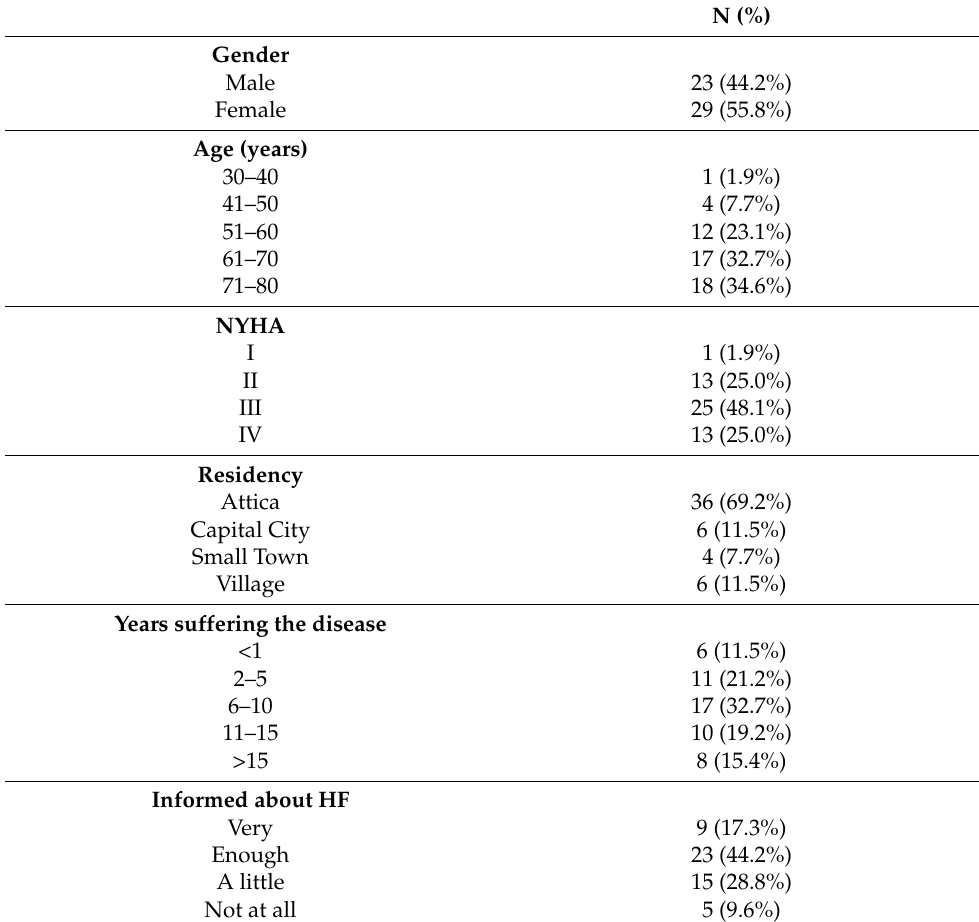
Table 1. Sample Description (N =